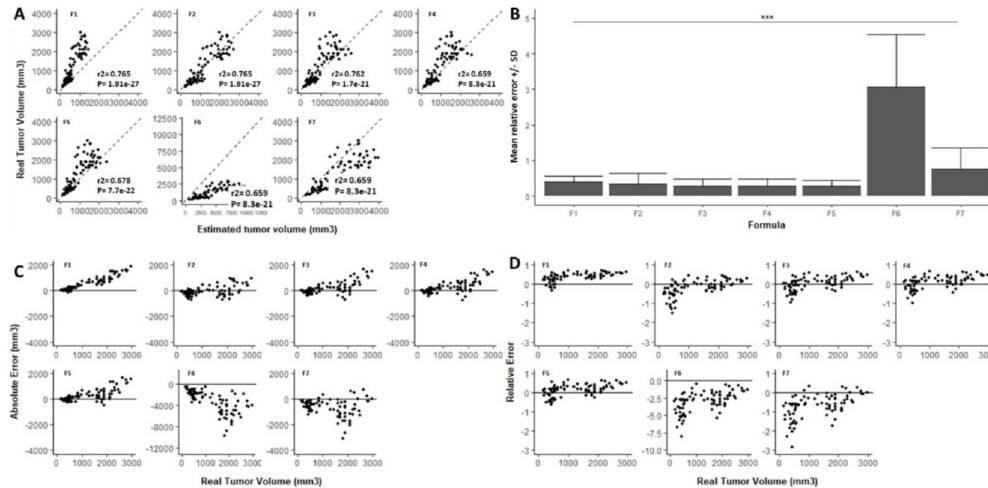
Fig 2. (A) Correlation graphics between real tumor volume (i.e., tumor mass) and estimated tumor volume with Formula 1 (F1), Formula 2 (F2) Formula 3 (F3), Formula 4 (F4), Formula 5 (F5), Formula 6 (F6) or Formula 7 (F7) (n = 83). Dotted line is a representation of y = x and the black dots are our observed data (n = 83). (B) Bar plot of Mean relative error ± SD for all tested volume estimation formulas: F1, F2, F3, F4, F5, F6 and F7 (C) Absolute error sorted by real tumor volume for F1, F2, F3, F4, F5, F6 and F7 (n = 83) (D) Relative error sorted by real tumor volume for F1, F2, F3, F4, F5, F6 and F7 (n = 83). ��� : p = 2.10–16 SD = standard